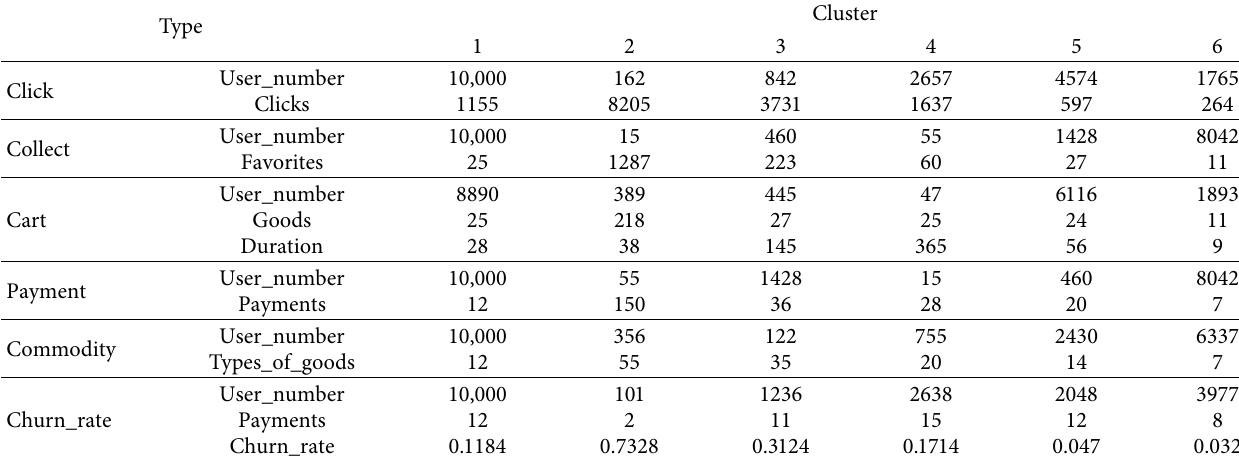
Table 2: Cluster analysis results using the optimized K -means